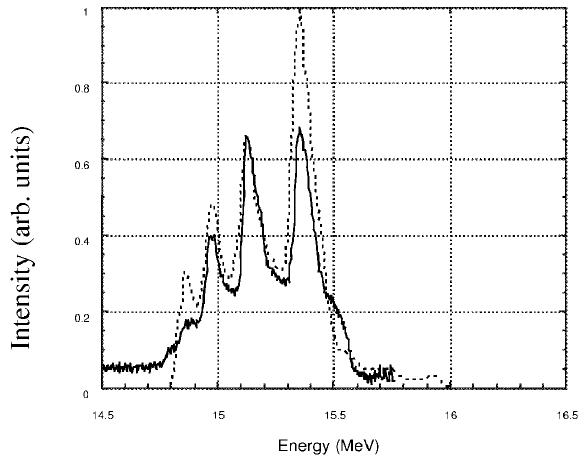
FIG. 8. Energy spectrum of the 4 3 4.8 nC bunch train. The solid line is the measured energy spectrum and the dotted line is the analytic fit.